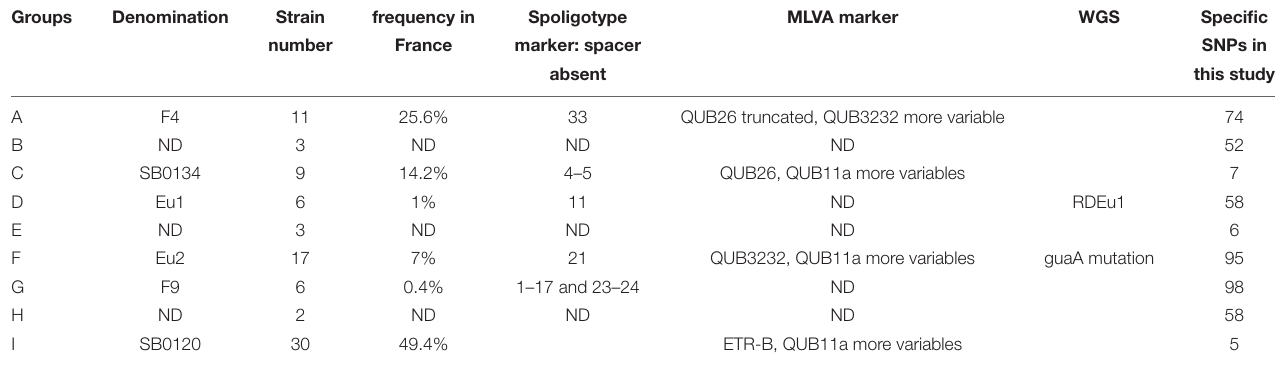
TABLE 2 | Definition and characteristics of the phylogenetic groups of M. bovis identified in France.